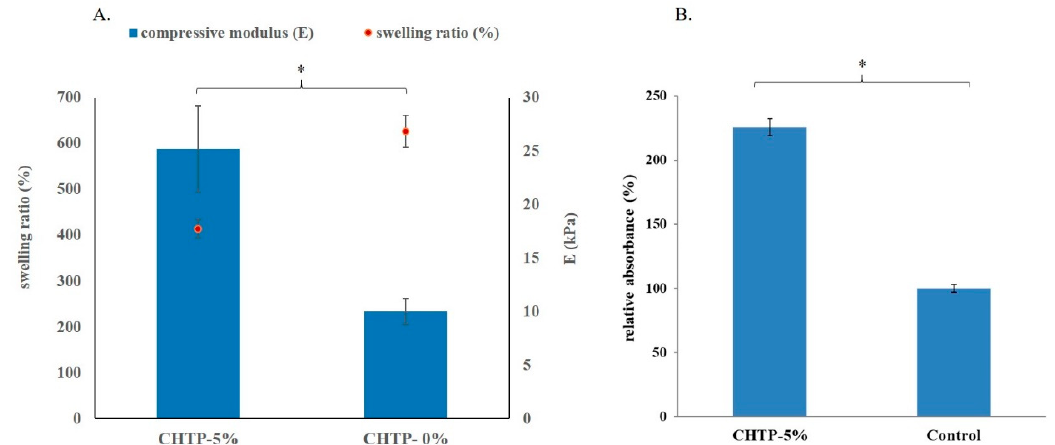
Figure 7. ( A ) Swelling ratio (%) (data collected at soaking time of 120 min) (left y-axis) and compression modulus (E) (right y-axis) of CHT with and without OPCs added. CHTP-5% represents that 5% OPCs were applied to a CHT composite with 30% ( w / w ) of β -TCP added (CHT-30% or CHTP-0%); ( B ) Cell viability evaluated by MTT assay for CHTP composite material. Cell growth is expressed as the relative absorbance obtained over the control condition. Error bars represent standard deviations of triplicate measurements. * indicates significant difference ( p < 0.05).